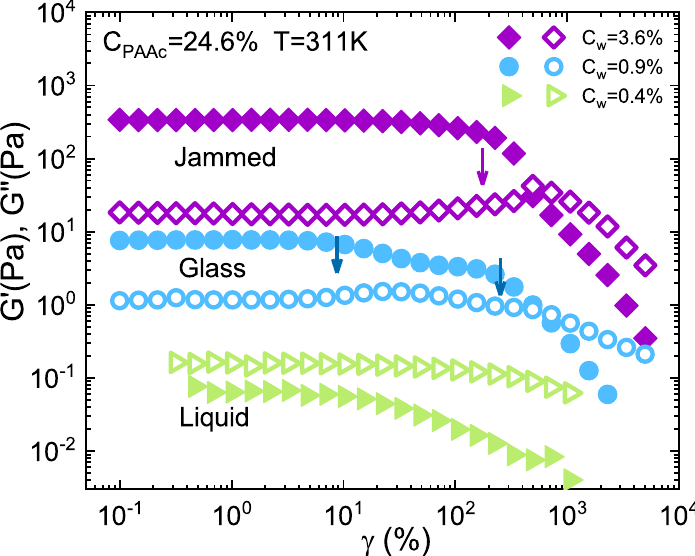
Figure 8. Storage G ’ (filled symbols) and Loss G ” (open symbols) moduli versus strain γ for IPN microgels at C PAAc = 24.6%, T = 311K and at different weight concentrations in the glass and jammed states. The arrows indicate the different breaking